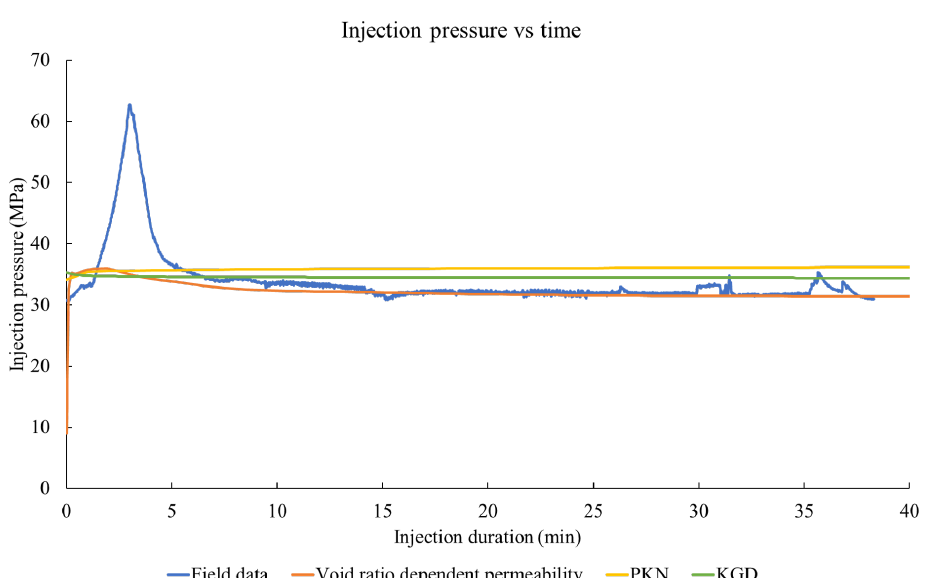
Figure 8. The injection pressure comparison between Equivalent Continuum Methods (ECM), Perkins–Kern–Nordgren (PKN), and Khristianovic–Geertsma–de Klerk (KGD) models against the field observation. As it is observed, the analytical solutions slightly overestimate the injection pressure while ECM shows a good